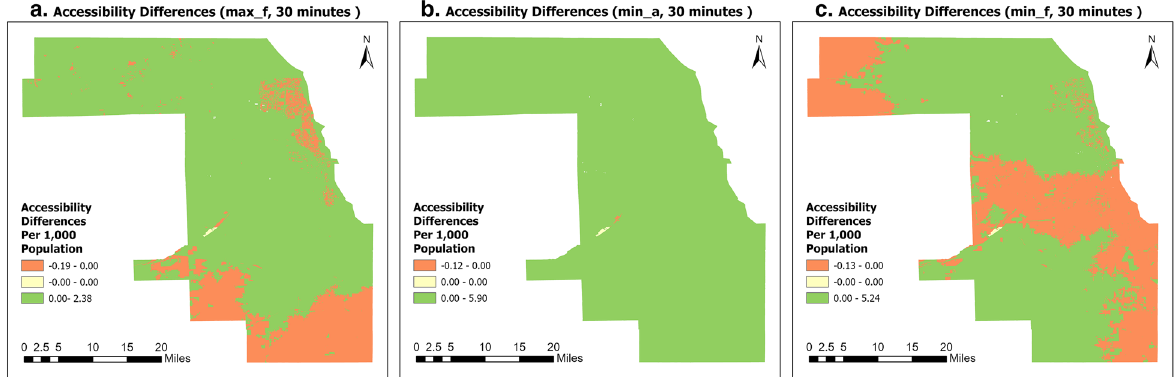
Fig. 7 Differences between 2SVCA and